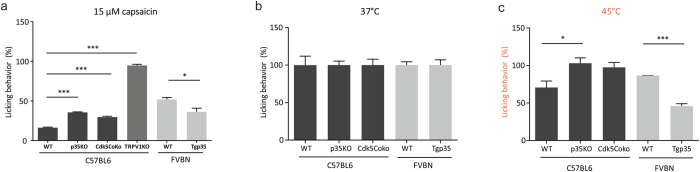
Responses of wild-type, p35KO, Cdk5CoKo, TRPV1KO, and Tgp35 mice to capsaicin and heat.Water-deprived C57Bl6 and FVBN mice were tested for 1 h using the lickometer with a free access to water containing 15 μM capsaicin. The behavior is expressed as a % of the baseline licking responses for plain water as compared to capsaicin. Increased aversion and hypersensitivity to capsaicin was evident in Tgp35 mice (FVBN background) by decreased number of licks (unpaired t-test, p < 0.05). In contrast, p35 knockout or Cdk5CoKo mice (C57BL6/129SVJ background) showed less aversion to capsaicin compared to their littermate wild-type (WT) controls (One-way ANOVA followed by Dunnett’s multiple comparisons test, p < 0.0001). Data are presented as mean ± SEM from four animals during five different measurements (a). Effect of temperature activation of TRPV1 in mutant animals. An orofacial pain assessment device was used to measure the responses of the mice to hot facial stimulation. All mice showed similar consumption of the reward (sucrose) at 37 °C (b). Tgp35 mice displayed an aversive behavior to the increased temperature of the thermodes as noted by significantly decreased licking behavior (unpaired t-test, p = 0.0002), whereas p35KO mice displayed significantly increased number of licks compared to wild-type controls (One-way ANOVA followed by Dunnett’s multiple comparisons test, p < 0.05) (c). Data are presented as mean ± SEM from four animals measured five times using 37 °C and three times at 45 °C.